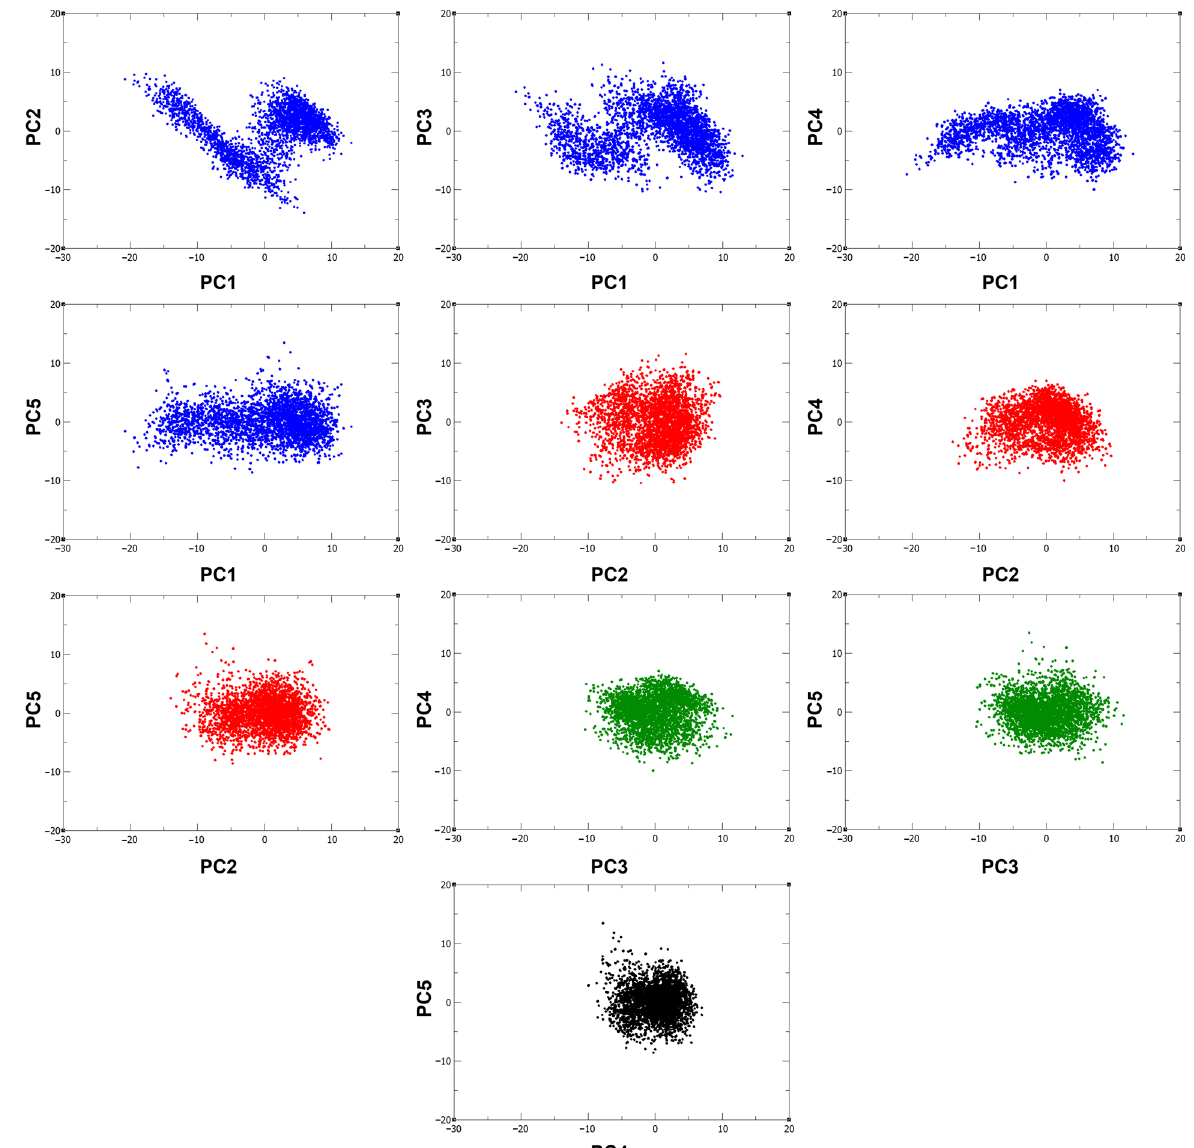
Figure 3. 2D projections of the 300 ns trajectory on the first five eigenvectors.